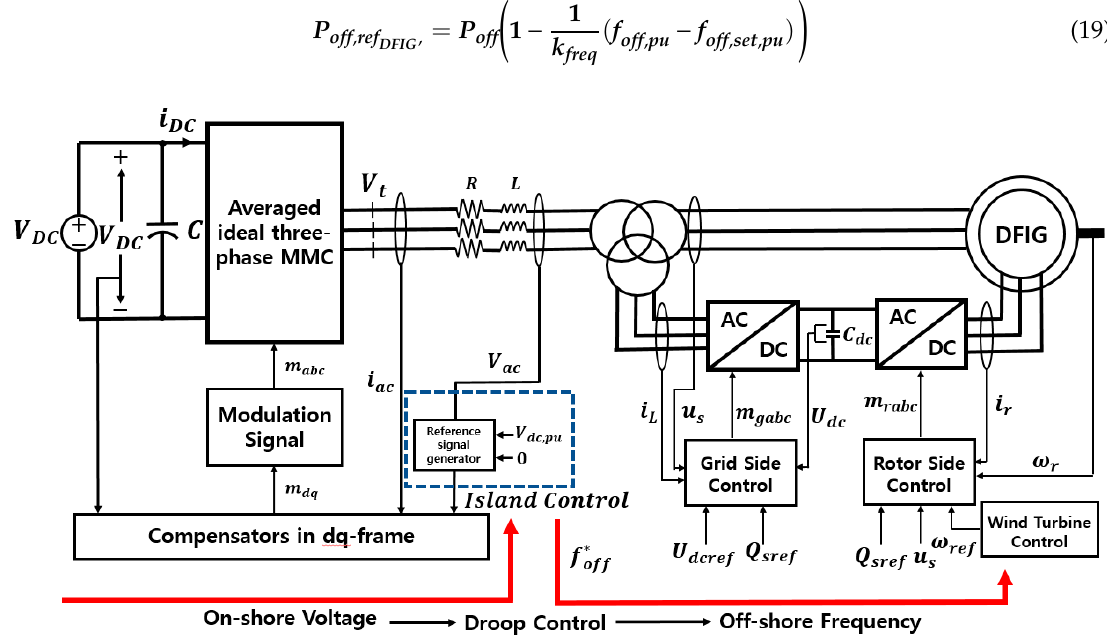
Figure 5. Off-shore DFIG wind farm with the MMC HVDC controller scheme.